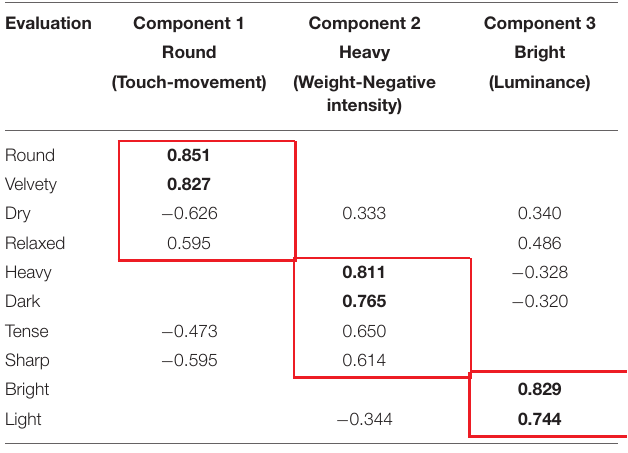
TABLE 6 | Factor loading after varimax rotation.